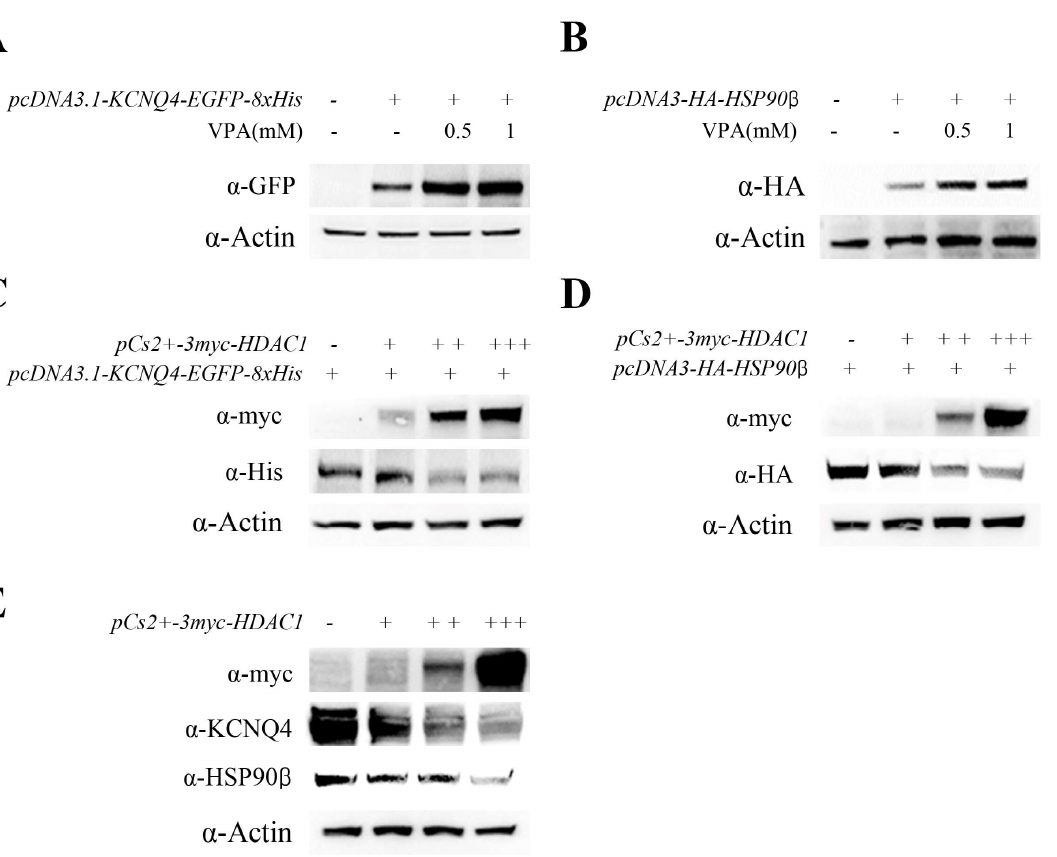
Figure 4. VPA increased KCNQ4 and HSP90β protein expression by inhibiting HDAC1. ( A ) VPA increased transient transfection of pcDNA3.1 − KCNQ4 − EGFP − 8xHis protein expression in HEK293T cells. ( B ) Transient transfection of pcDNA3 − HA − HSP90β increased protein expression in HEK293T cells treated with VPA. ( C ) Transient transfection of pcDNA3.1 − KCNQ4 − EGFP − 8xHis decreased by pCs2+ − 3myc − HDAC1 dose-dependent expression in HEK293T cells. ( D ) Transient transfection of pcDNA3 − HA − HSP90β decreased by pCs2+ − 3myc − HDAC1 dose-dependent expression in HEK293T